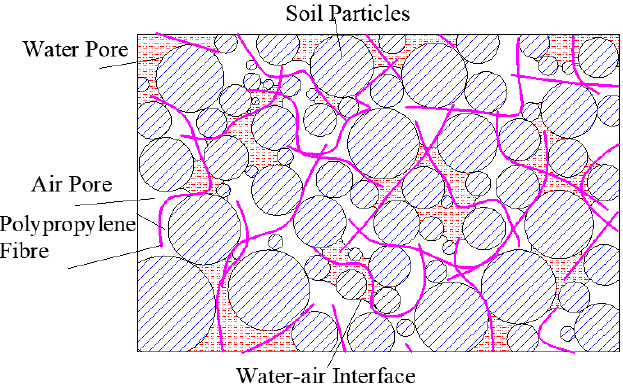
Figure 7. Schematic diagram of microstructure for fiber reinforced soil specimen.